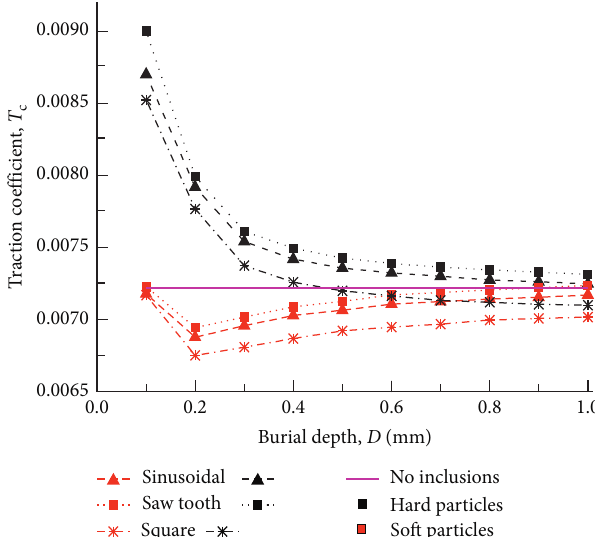
Figure 11: Effects of particle burial depth on the traction